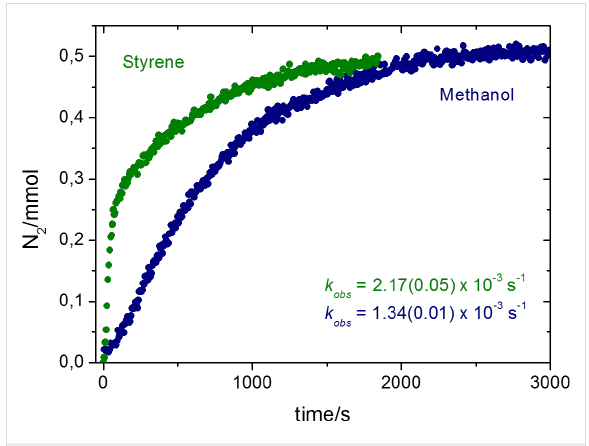
Figure 1: Plot of evolved nitrogen with time for the reactions of EDA with styrene or